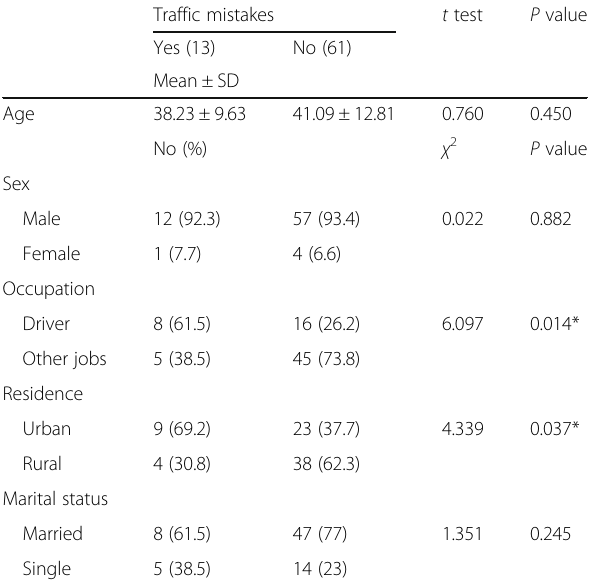
Table 4 Descriptive data according to the traffic mistakes in the